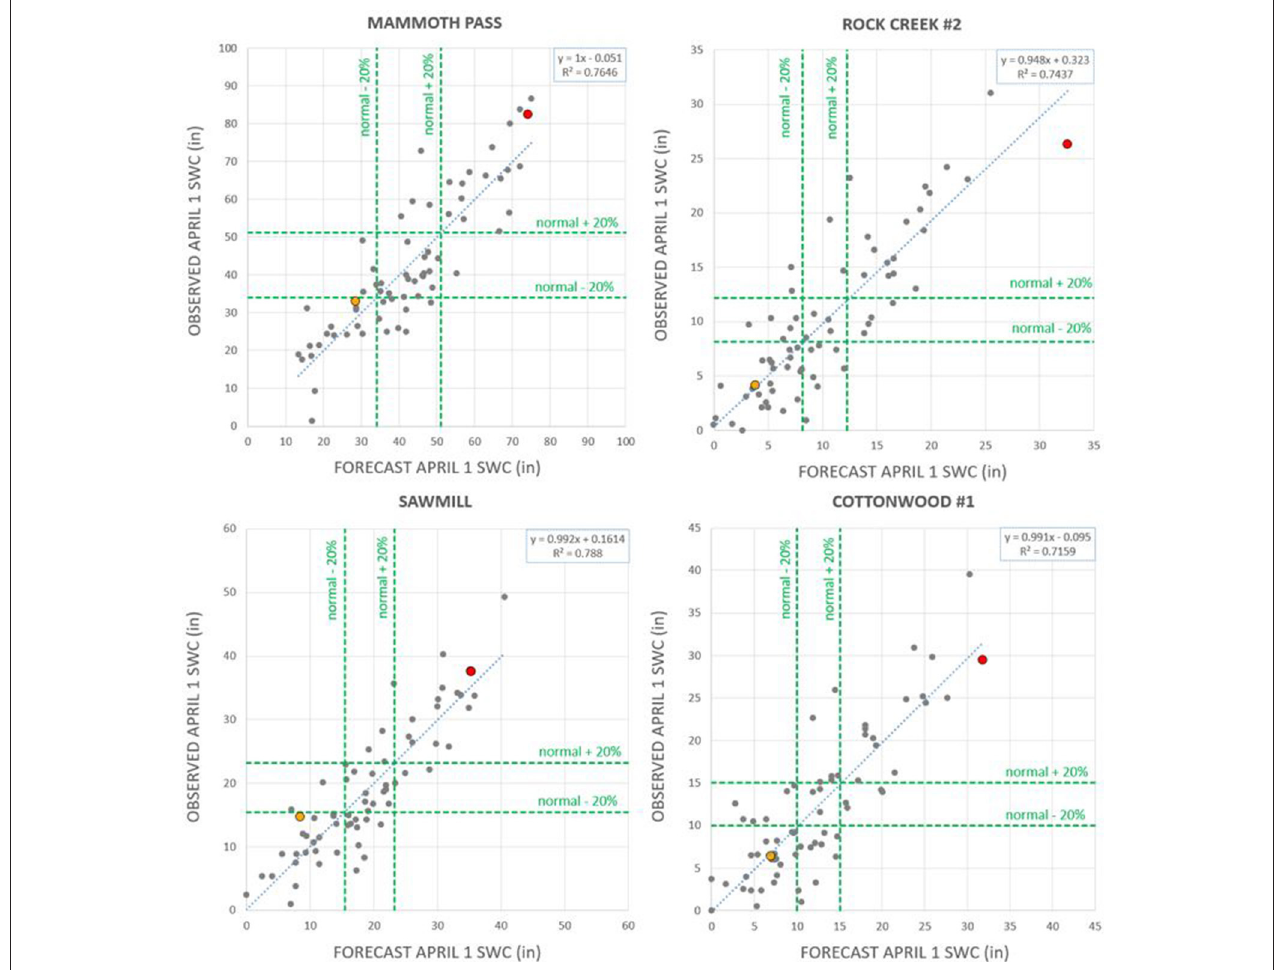
FIGURE 7 | Forecast for years 2017 (red) and 2018 (orange) plotted against the respective observations, for the four Owens Valley sites. The gray points represent 1951–2016 hindcasts, previously shown in Figure 4